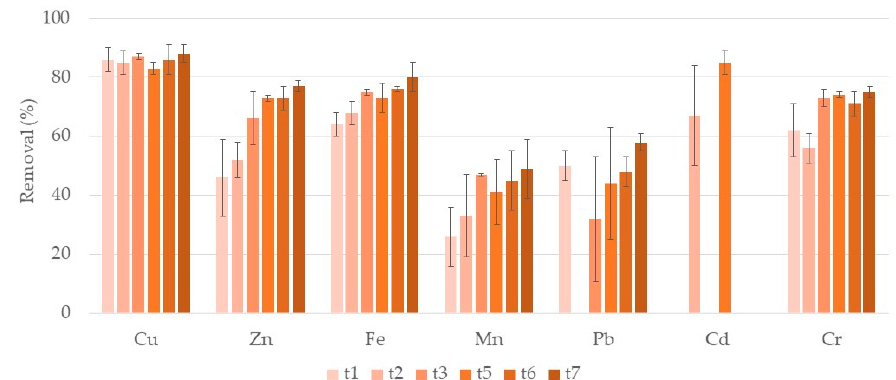
Figure 2. Removal percentage and respective standard deviation ( n = 3) for each metal, in CWs with lava rock (L) and P. australis during the first week of treatment. Samples taken after one day (t1), two days (t2), three days (t3), five days (t5), six days (t6), and seven days (t7) of treatment. For Pb, there was no removal at t2 and for Cd, there were no removals at t1, t3, t6, and t7.